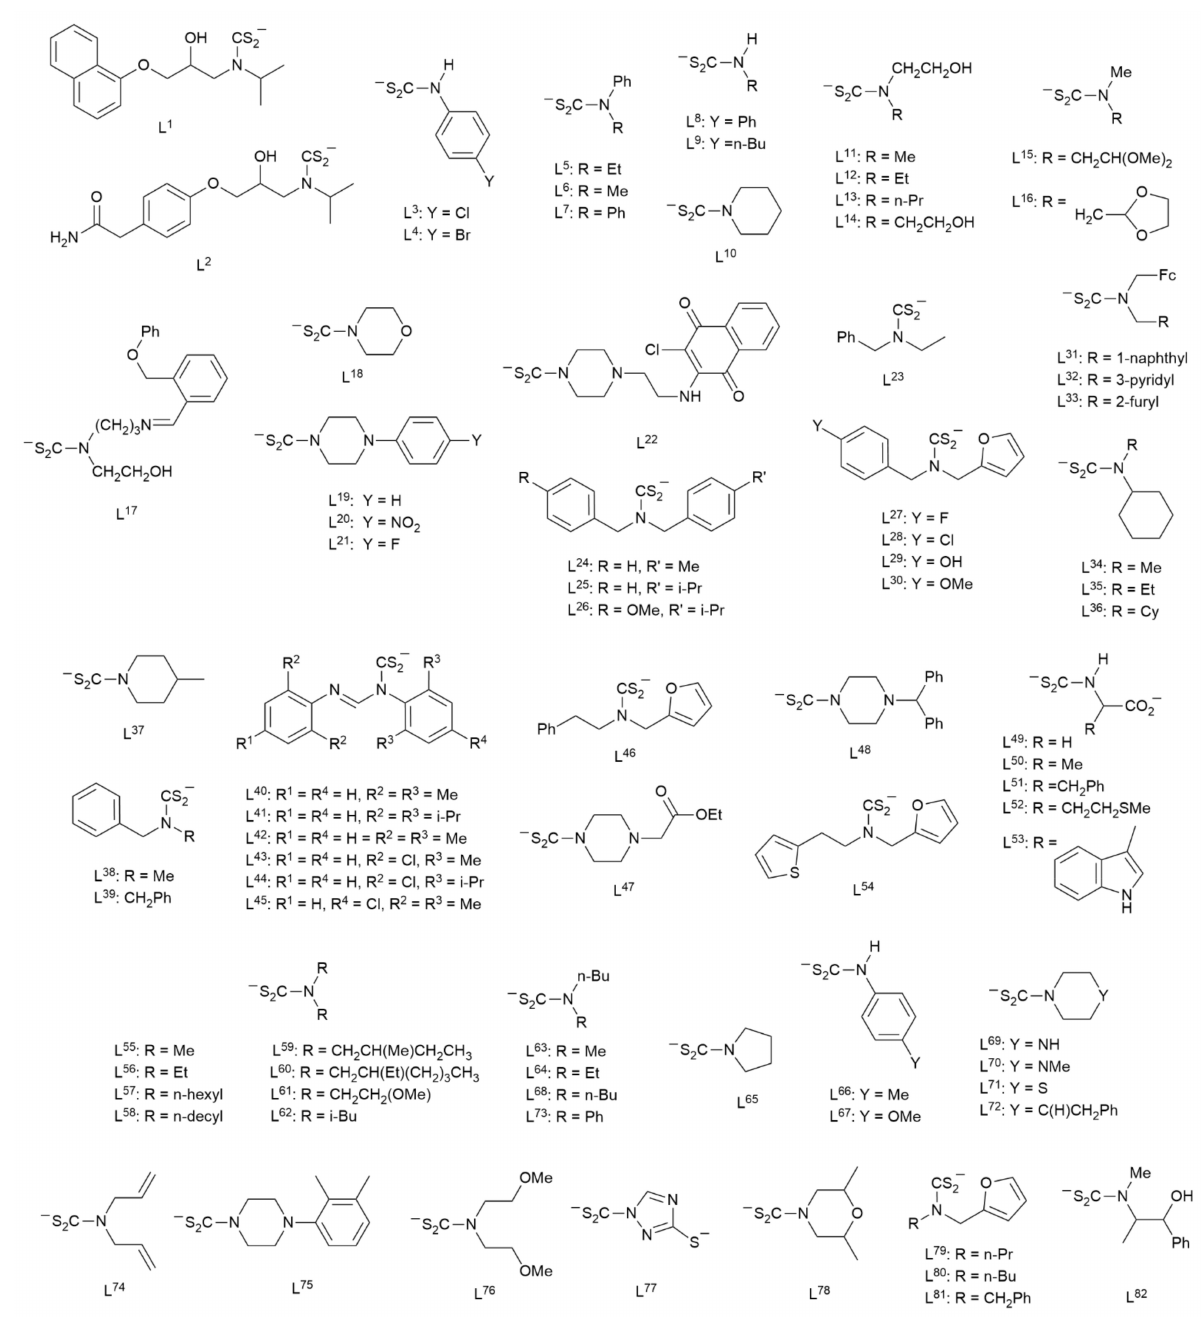
Figure 2. Chemical diagrams for dithiocarbamate anions L 1 to L 82 discussed herein. Fc is ferrocenyl, (C 5 H 4 )Fe(C 5 H 5